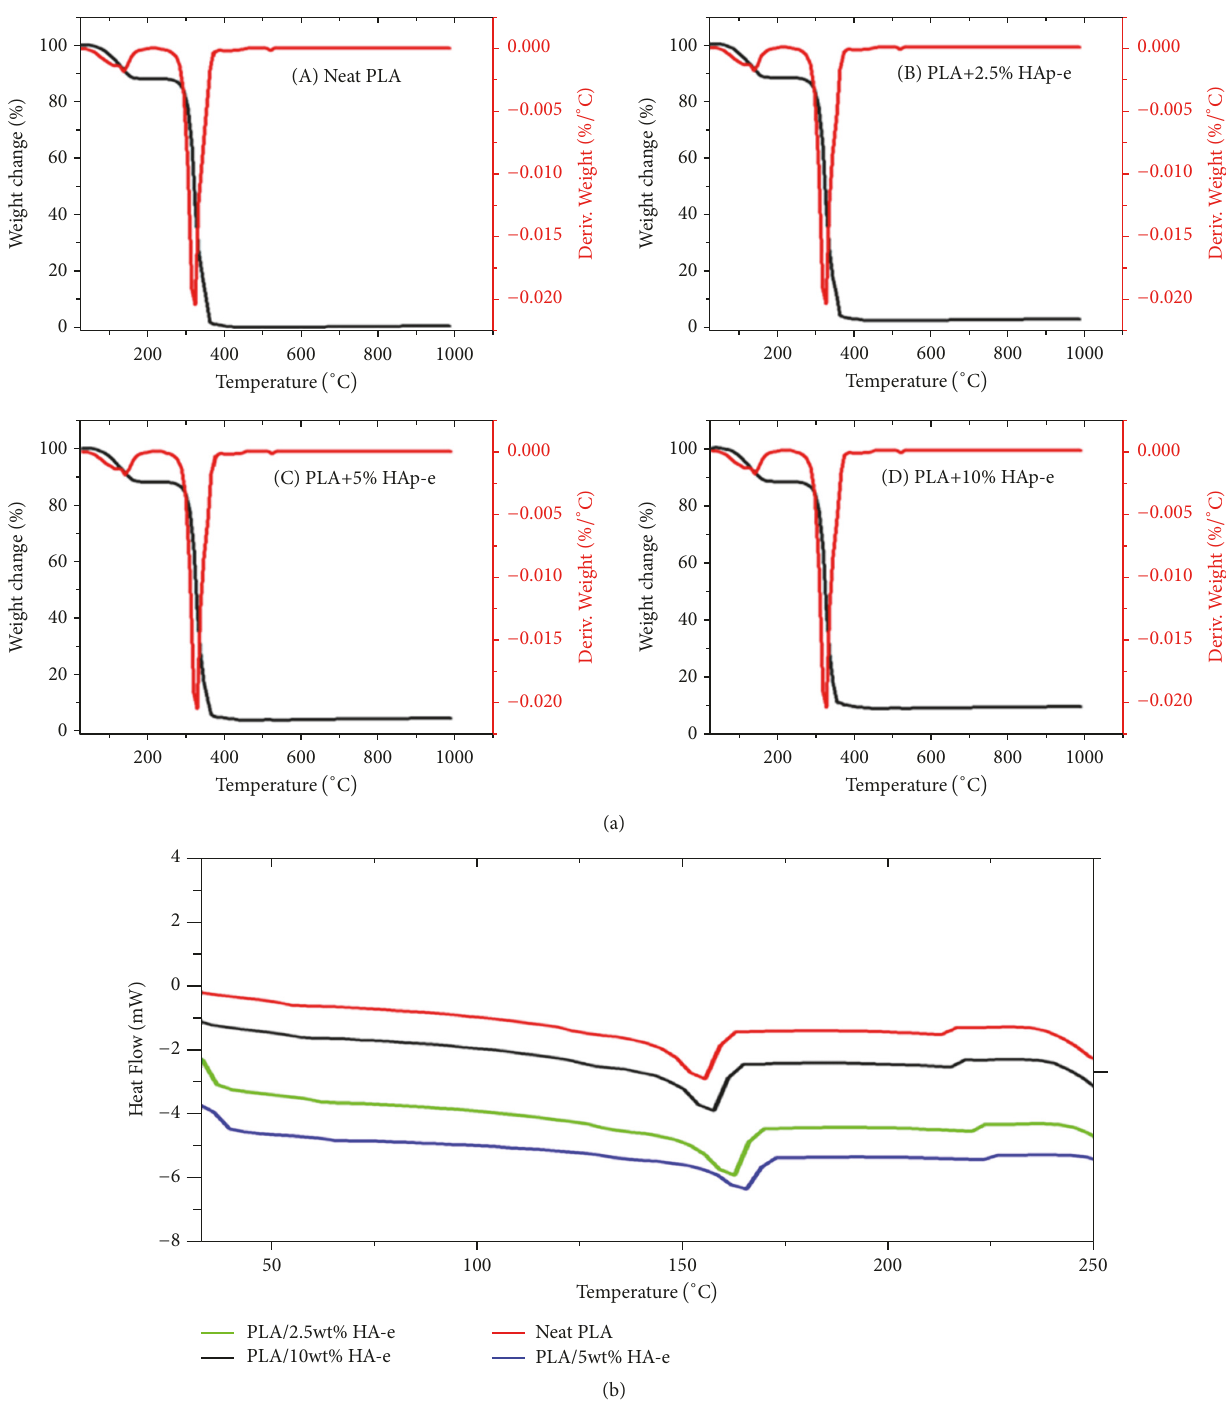
Figure 5: TGA (a) and (b) DSC curves of the electrospun neat PLA and PLA/EnHA